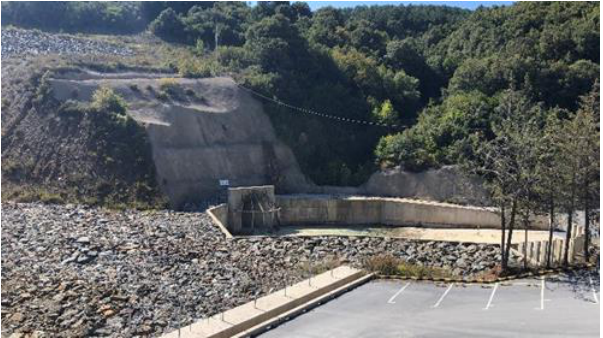
Figure 2. Diversion tunnel entrance portal.